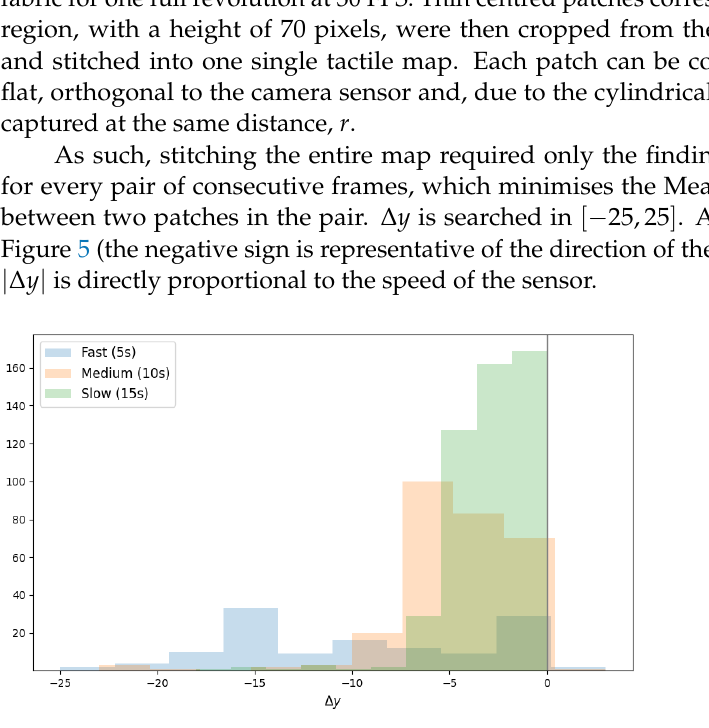
Figure 5. Histograms of the chosen ∆ y for the three motion